Question: Compose a caption that would accompany this figure in a paper.
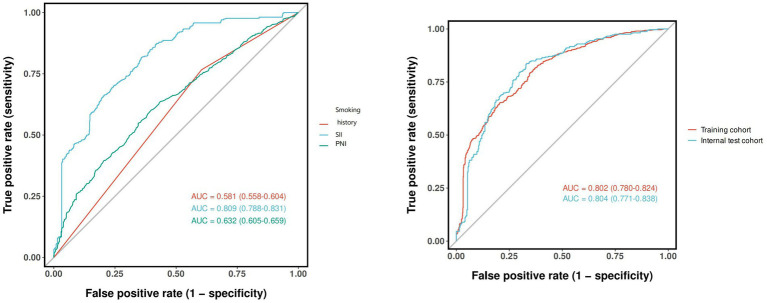
Answer: ROC curve of the training set.